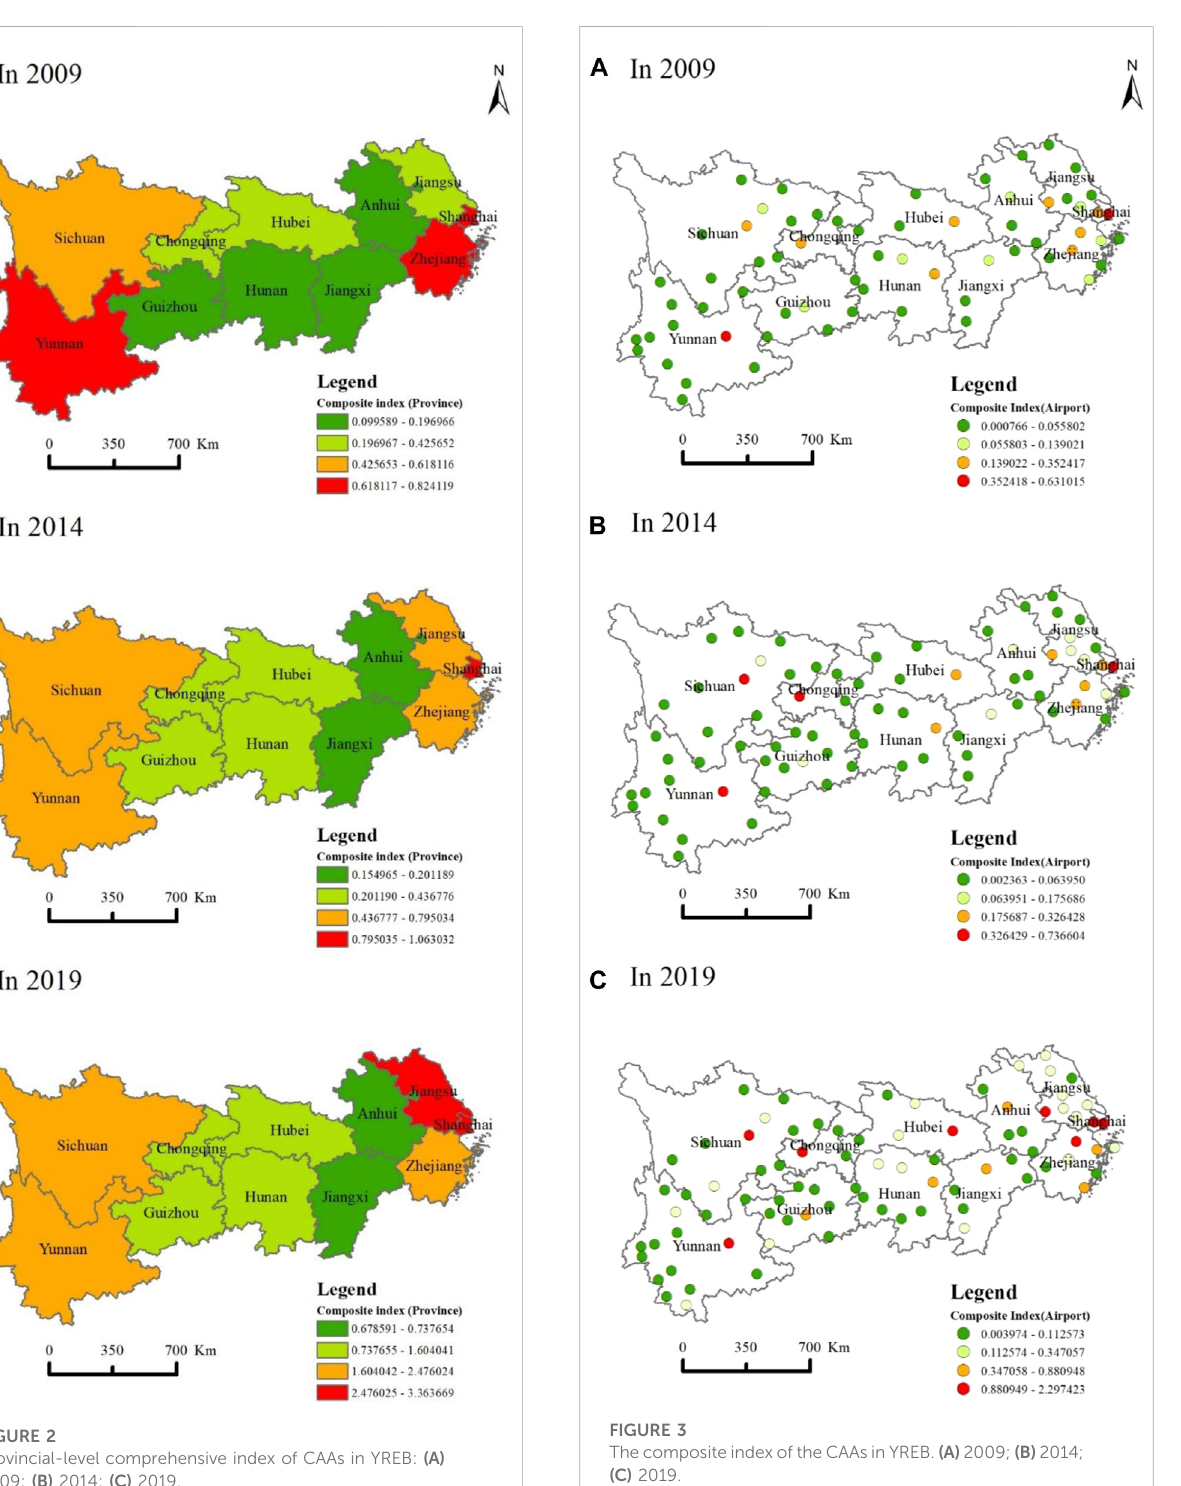
Different colors indicate the competitiveness level of airports. From high to low, competitiveness is re fl ected as red-orange- light green-dark green. It can be seen that, with the total index of